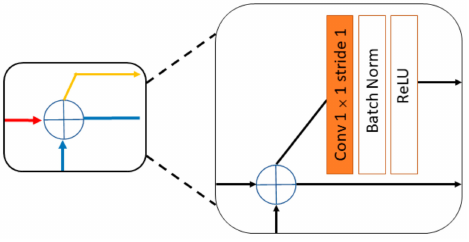
Figure 4. Architecture of the multi-scale feature extraction